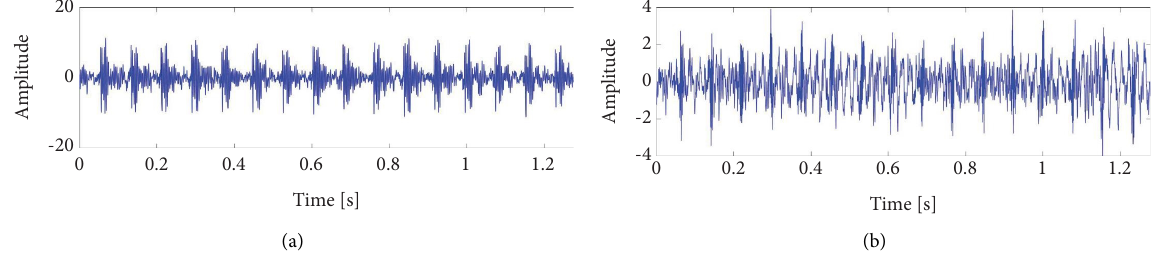
Figure 11: Reconstructed signal diagram. (a) An early reconstruction signal. (b) A late reconstruction